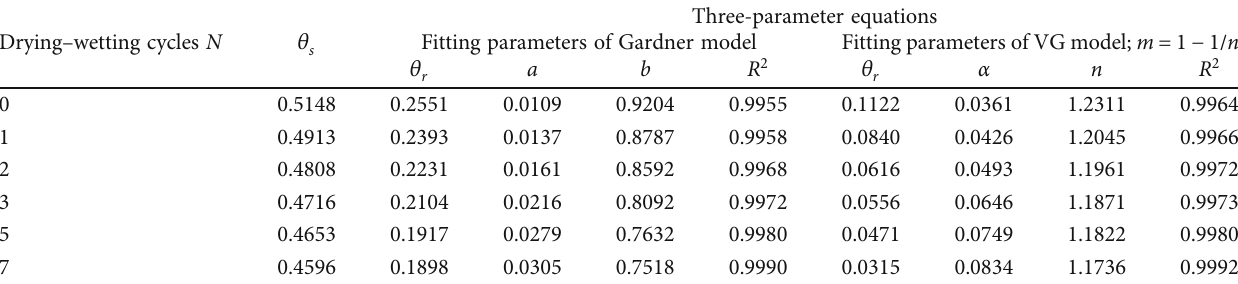
Table 3: Best- fi t parameters and R 2 values for the Gardner and VG model (three-parameter). Drying – wetting cycles N θ s